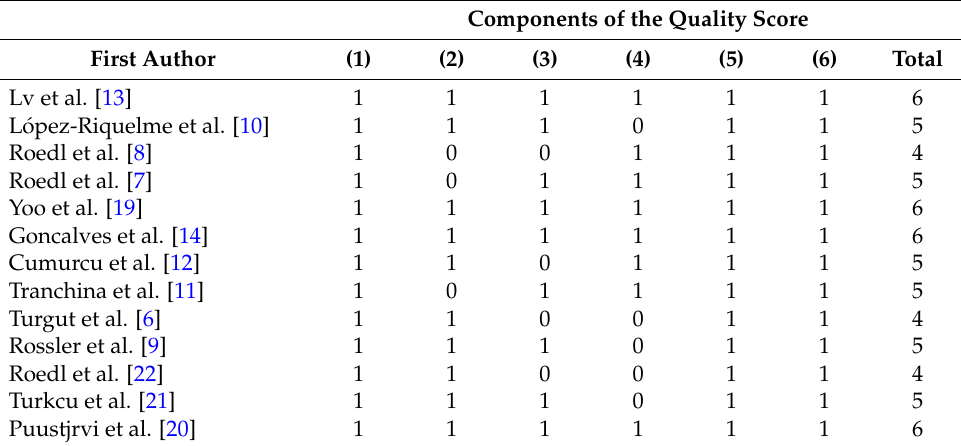
Table 2. Quality Scores of Individual Studies.